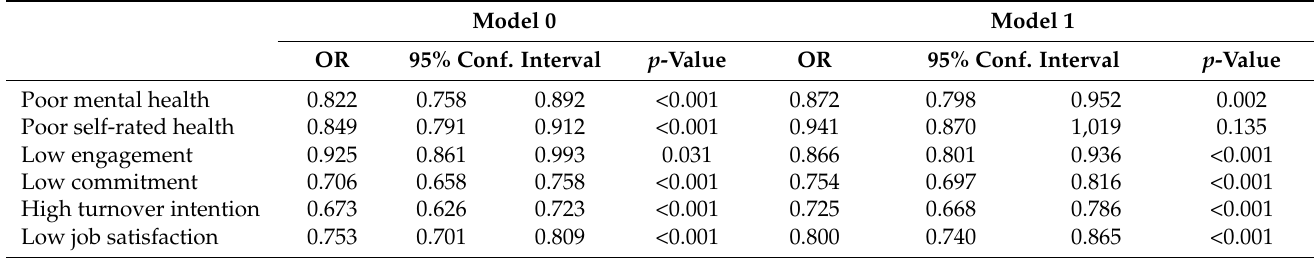
Table 2. Associations of EFCs (more vs. less) with health and job attitudes of employees. Model 0 Model 1 OR 95% Conf. Interval